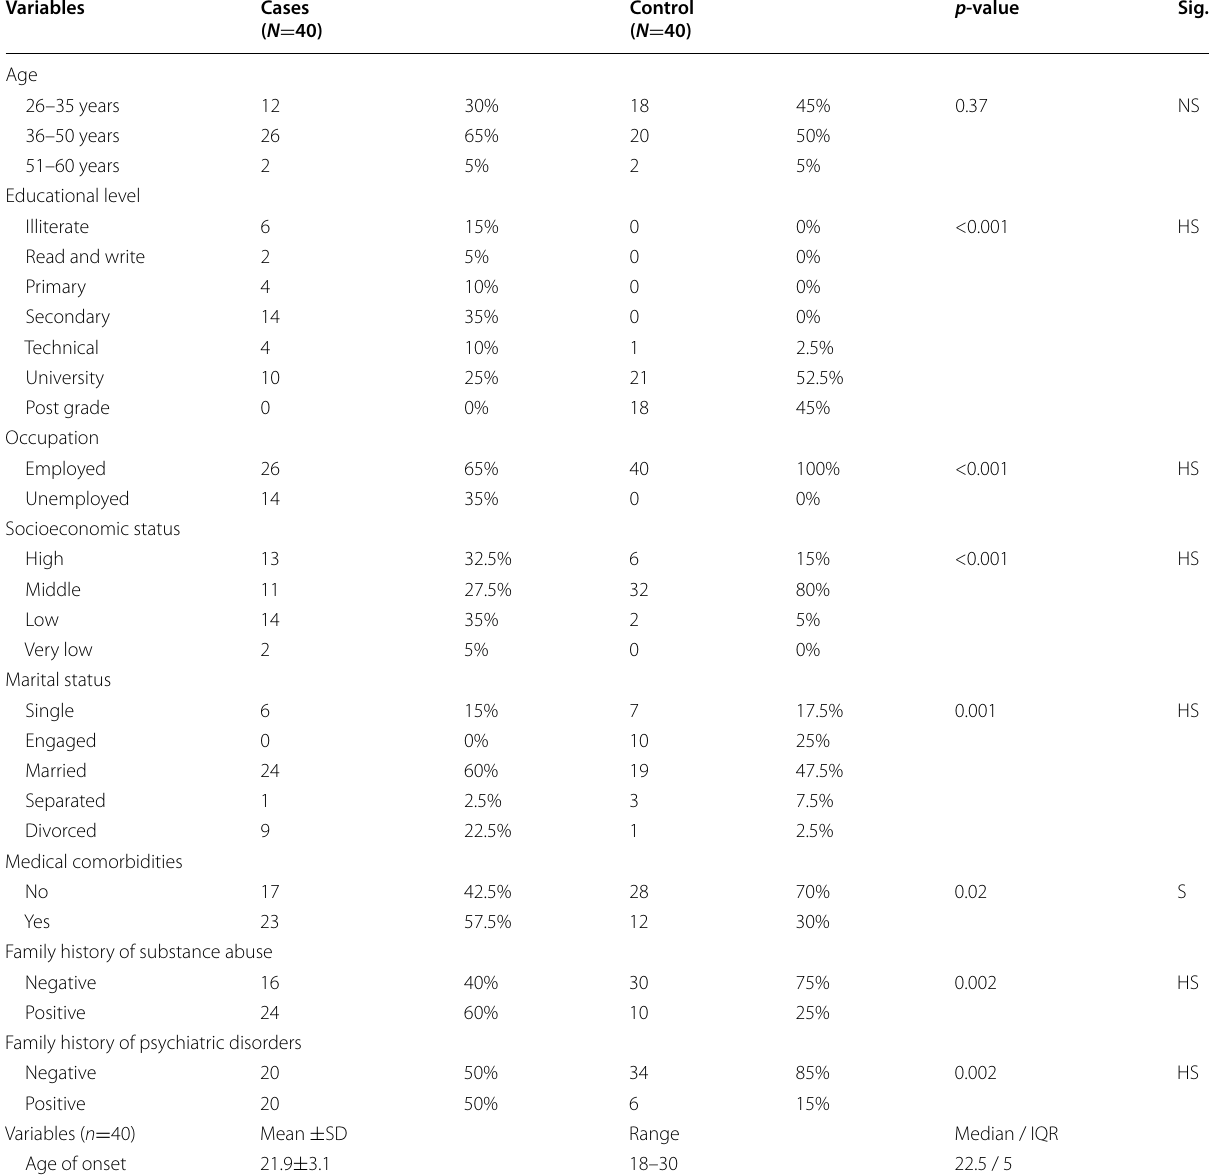
Table 1 Comparisons of demographic characters in different study